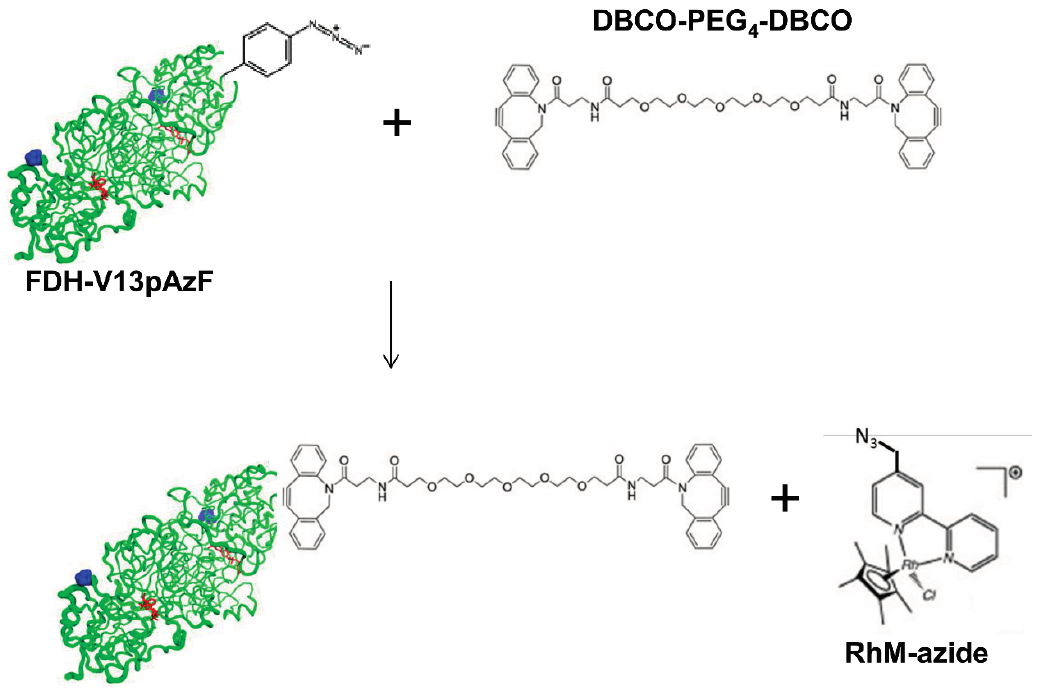
Figure 3. Schematic representation of conjugation of RhM-azide to TsFDH-V13pAzF via DBCO-PEG 4 -DBCO bifunctional linker through SPAAC. Not drawn to scale.